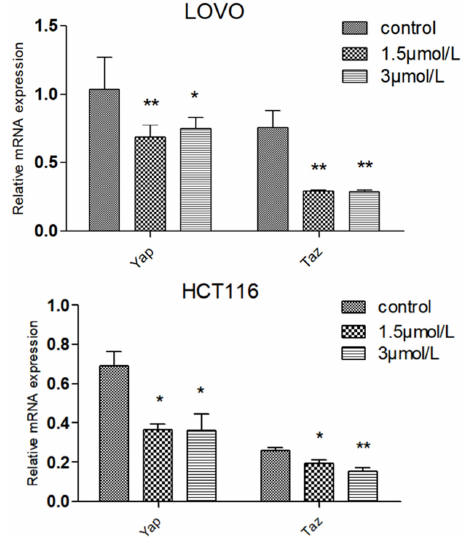
Figure 13. Electrophoretic grayscale values of Yaz and TAZ protein expression in colon cancer cells after DTB intervention. n = 3; compared with the blank group, * p < 0.05; ** p < 0.01, each data point represents the mean ± standard error.